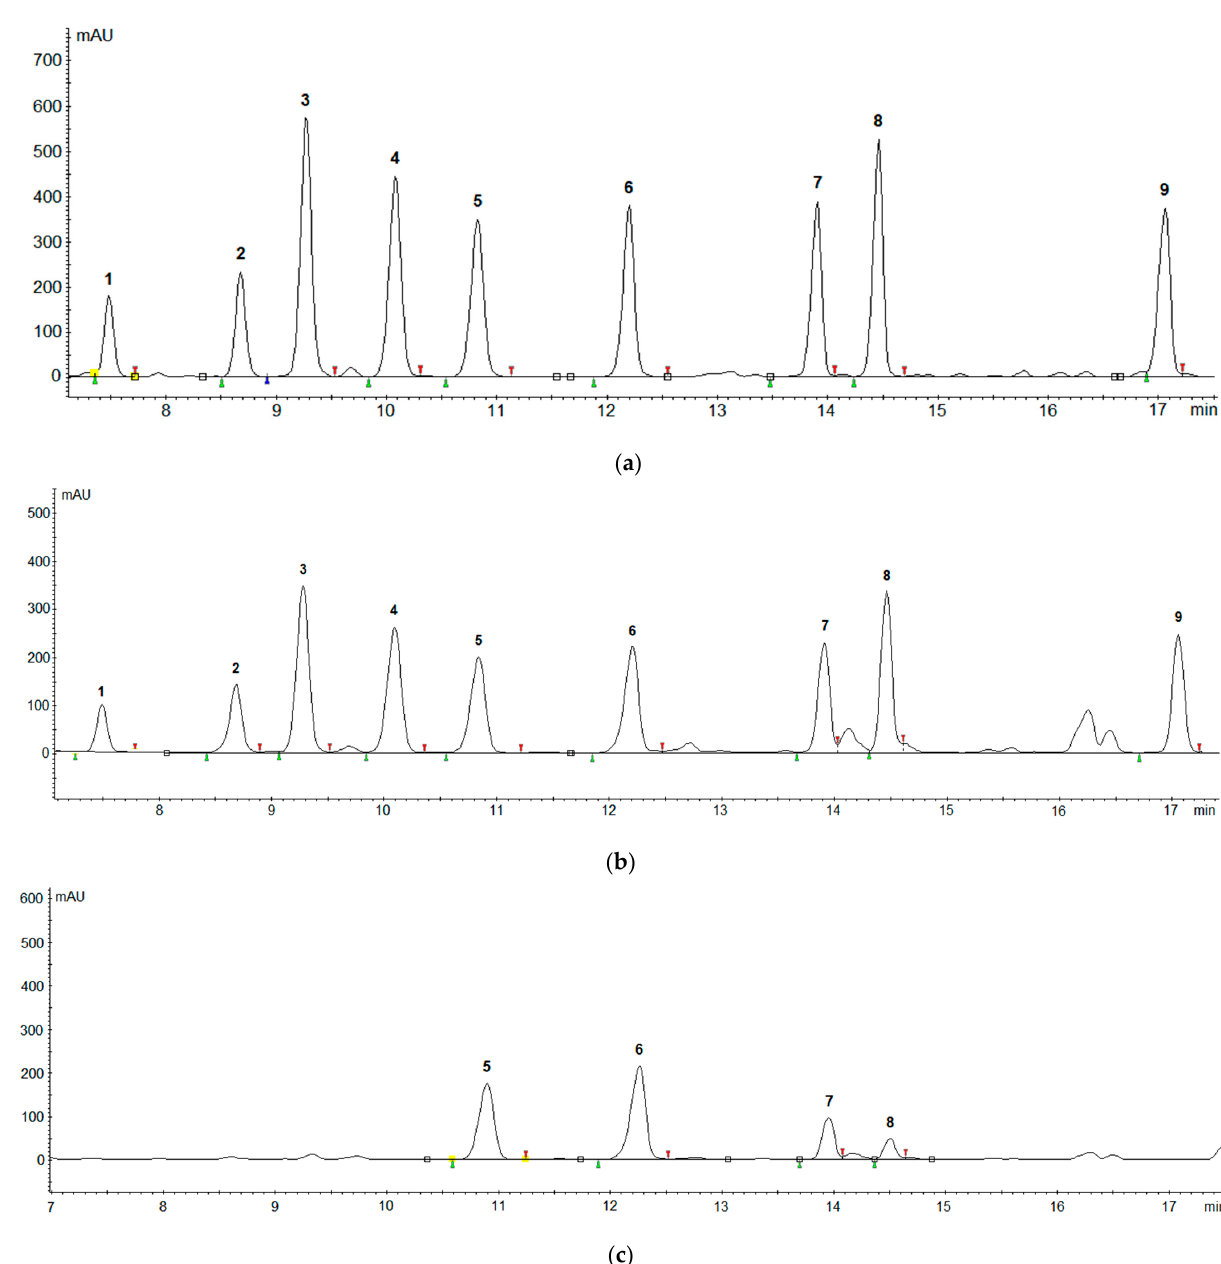
Figure 2. Chromatograms of standard solution with biogenic amines (25 µg/mL) ( a ), cheese sample (Camembert) spiked BAs at concentration of 100 mg/kg ( b ) and real cheese sample (Gorgonzola) with biogenic amines detected ( c ). Identification of the peaks: 1—tryptamine, 2—2-phenylethylamine, 3—putrescine, 4—cadaverine, 5—histamine, 6—1,7-diaminoheptane (IS), 7—tyramine, 8—spermidine, Table 5. The content of biogenic amines (TRYP—tryptamine, PHE—2-phenylethylamine, PUT—putrescine, CAD—cadaverine, HIS—histamine, TYR—tyramine, SPD—spermidine,